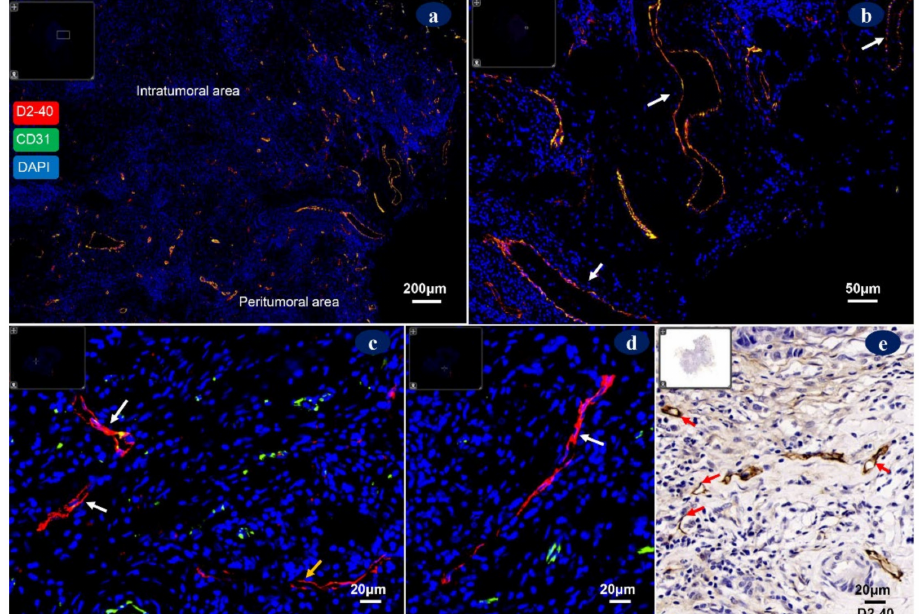
Figure 4. Double D2-40/CD31 immunofluorescence labeling was utilized to visualize distribution pattern and morphology of tumor-associated lymphatic vessels in breast cancer tissues. ( a ) Continu- ous D2-40-positive and discontinuous CD31-positive lymph vessels are mainly present in peritumoral area, but are negligible in intratumoral area (50 × ). ( b ) D2-40-positive large dilated lymphatic vessels in peritumoral area (white arrows, 200 × ). ( c ) D2-40-positive collapsed vessels (white arrows) and long narrow lymphatic vessel (yellow arrow, 400 × ) in intratumoral areas. ( d ) D2-40-positive lymphatic endothelial bundle (white arrow, 400 × ) in intratumoral areas. ( e ) D2-40-positive tumor-associated lymphatic endothelial cells (red arrows, 400 × ) in intratumoral areas. Protocols for immunofluores- cence and immunohistochemistry stainings were stated in Appendix A and the antibodies used were shown in Table